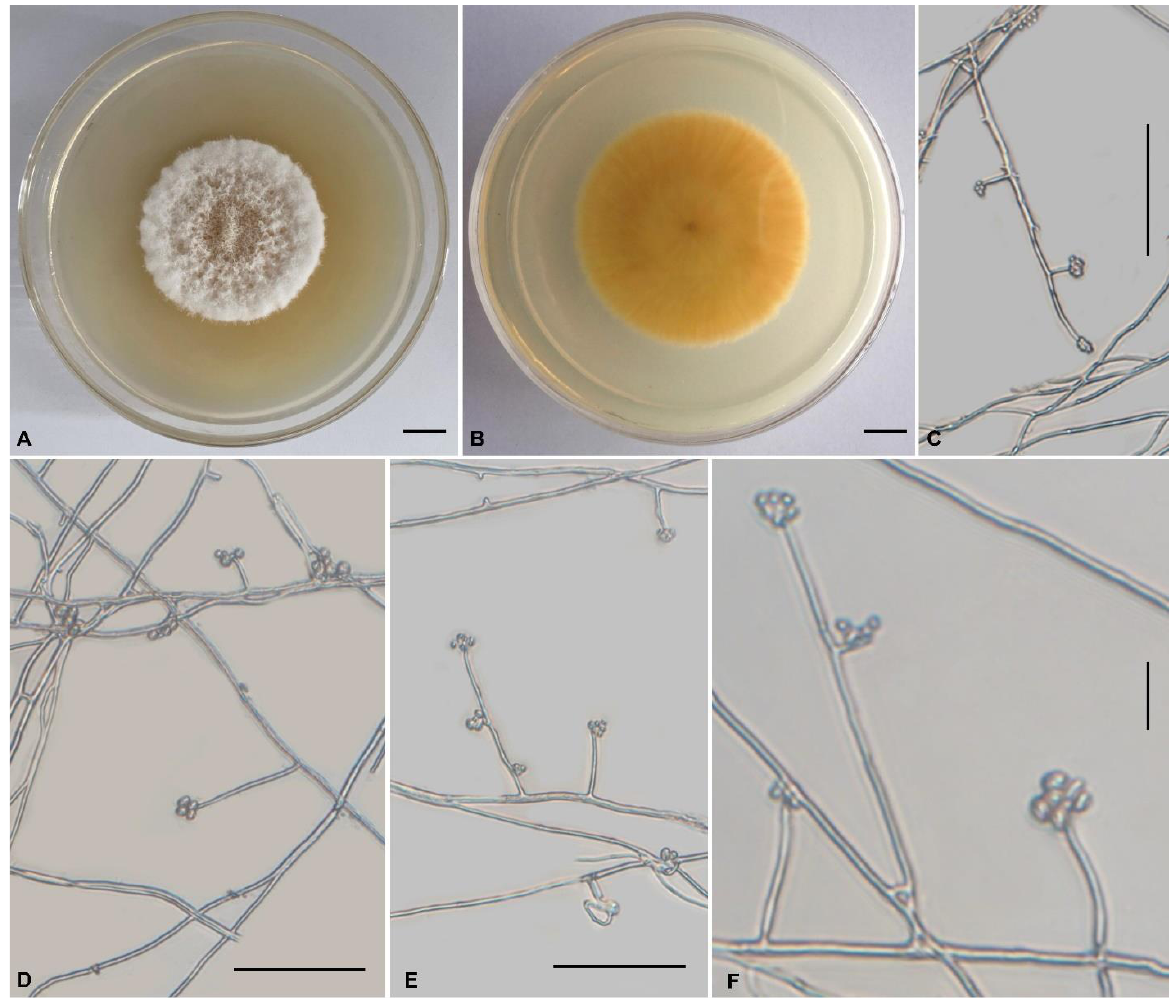
Figure 4. Morphology of Tolypocladium subparadoxum (YFCC 879, ex-type living culture). ( A , B ) Culture characteristics on PDA medium incubated at 22 °C for 21 days; ( C – F ) phialides and conidia. Scale bars: A – B = 10 mm; C – E = 50 μm; F = 20 μm.